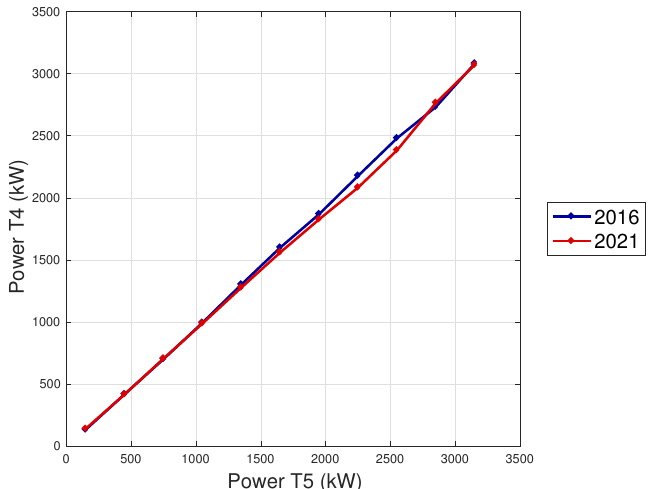
Figure 13. Power of T4 as a function of the power of T5, computed using the binning method: 2016 and 2021.